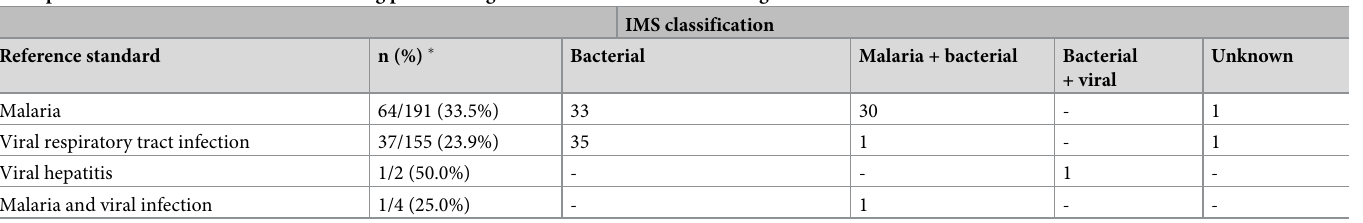
iNTS: invasive non-Typhoidal Salmonella | � n: Total number of false negative cases per bacterial species. False positive IMS bacterial inflammation flag presented against the classification according to reference